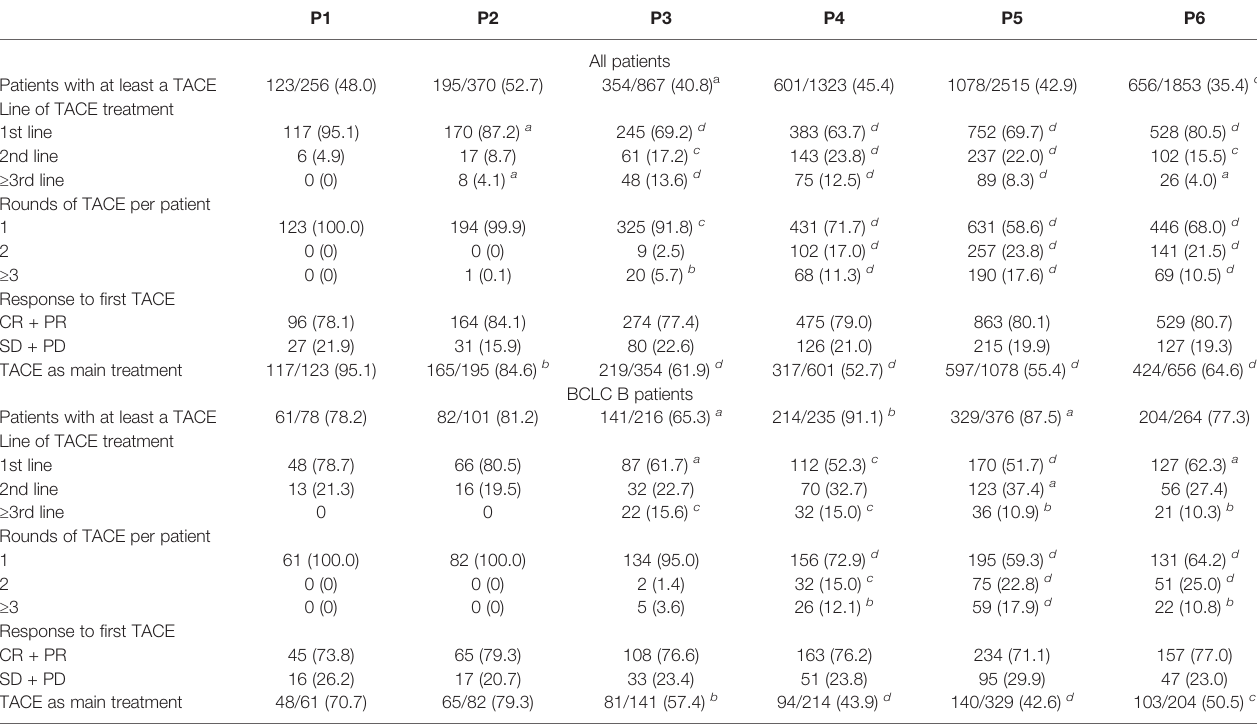
TABLE 5 | Characteristics of TACE treatment in the different calendar periods.